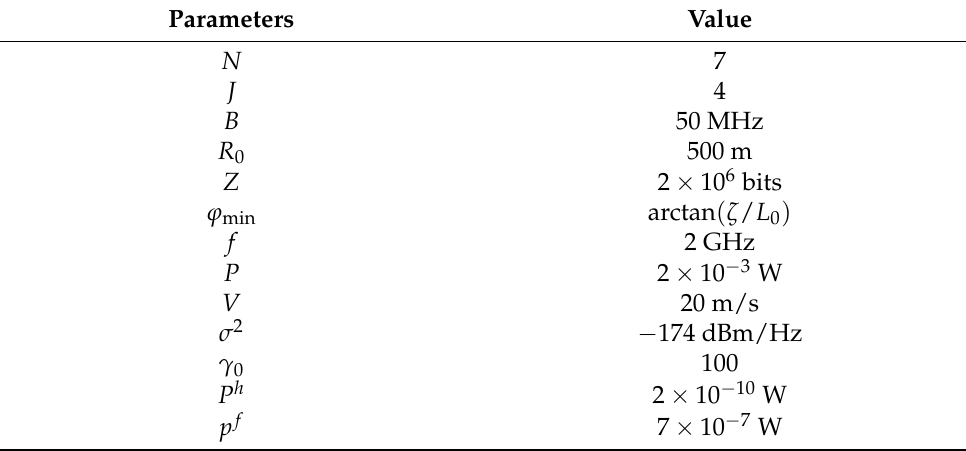
Table 1. Simulation